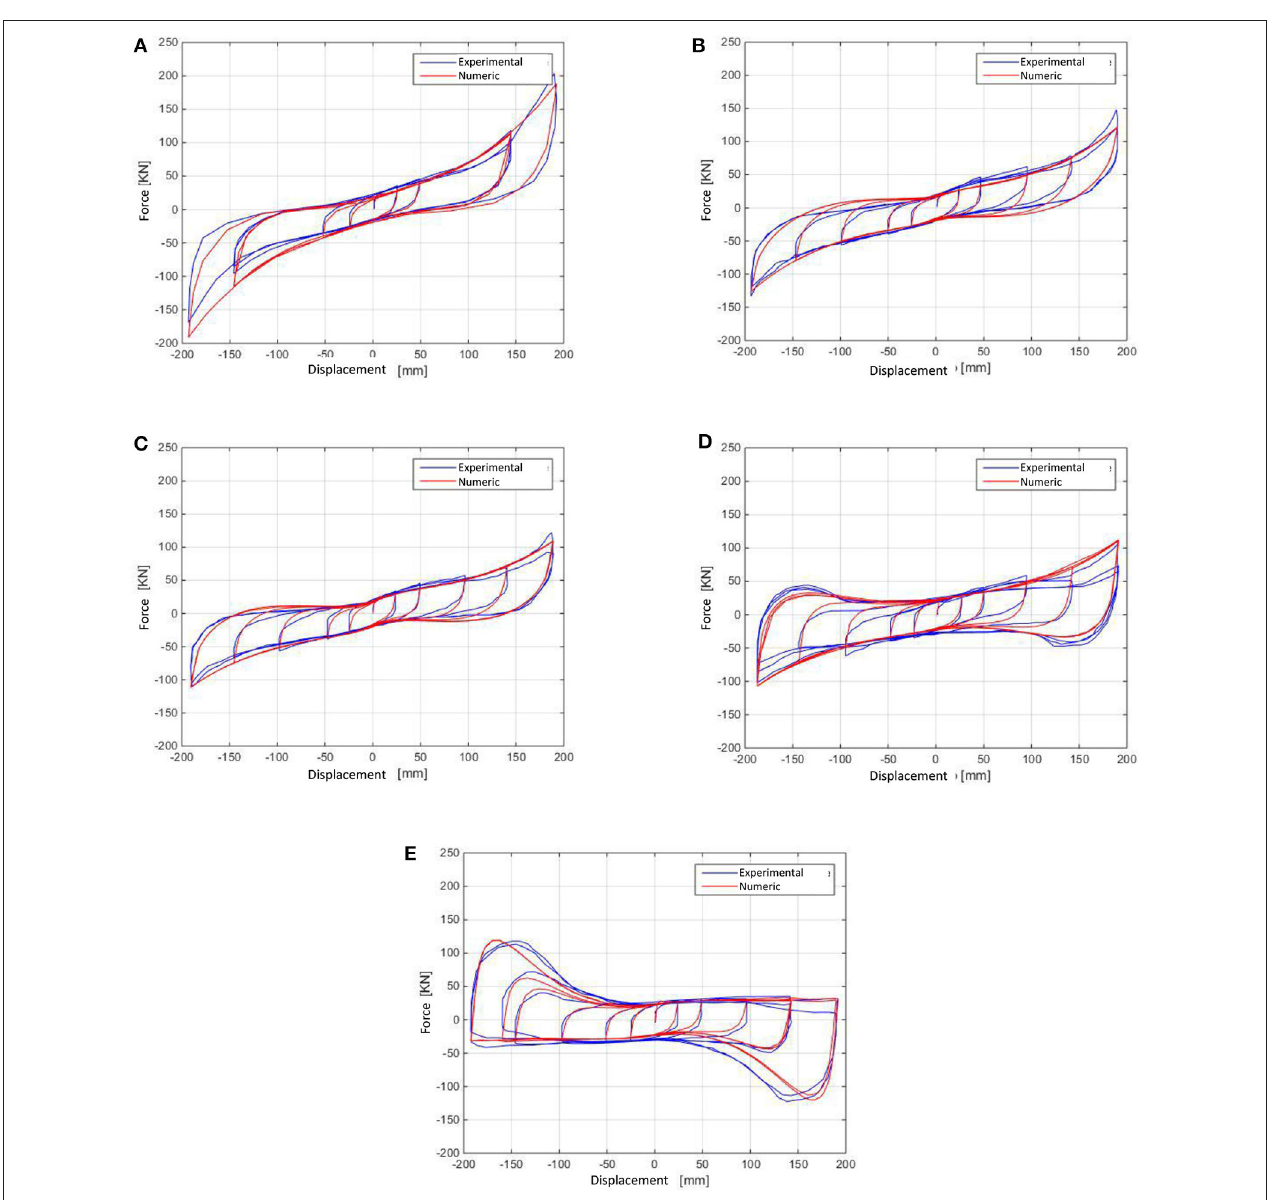
FIGURE 3 | Human-driven method: cyclic shear test of the tested isolator (50, 100, 200, 300, and 400% deformations for compression stresses of 0 MPa (A) , 5 MPa (B) , 10 MPa (C) , 20 MPa (D) , 30 MPa (E) . Comparison between model (parameters in Table 2 ) and experimental results.